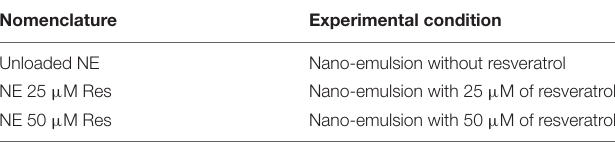
TABLE 1 | Definition of nomenclature used for all experimental